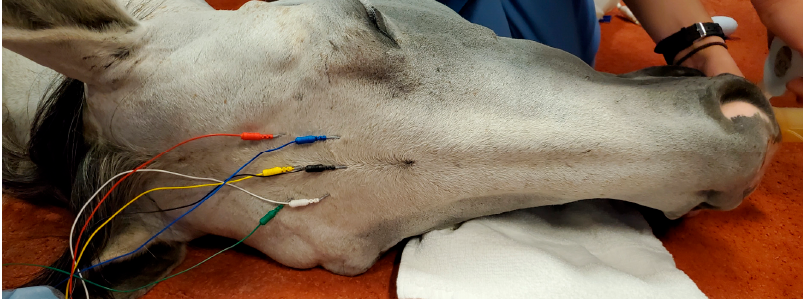
Figure 1. The needle electrodes were placed on the forehead of a horse soon after anesthetic induction. The needle electrode wires were color-coded and corresponded to the Sedline ® electrode R1 (white color wire), positioned at an approximation of the Fp2, R2 (green color wire), positioned between F4–F8, L1 (blue color wire), positioned at an approximation of the Fp1, and L2 (red color wire), positioned between F3 and F7. The CB—Ground (black color wire) and the CT—Reference (yellow color wire) electrodes were placed on the mid-sagittal line in the central and the caudal position, respectively.